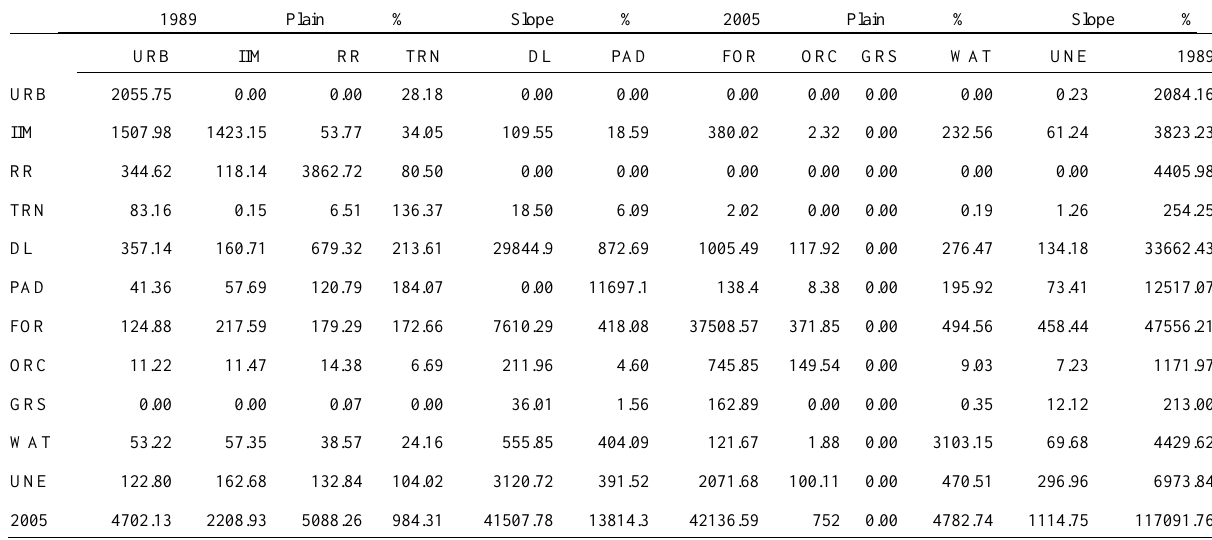
Table 6. Land use change matrix in Longtan district between 1989 and 2005